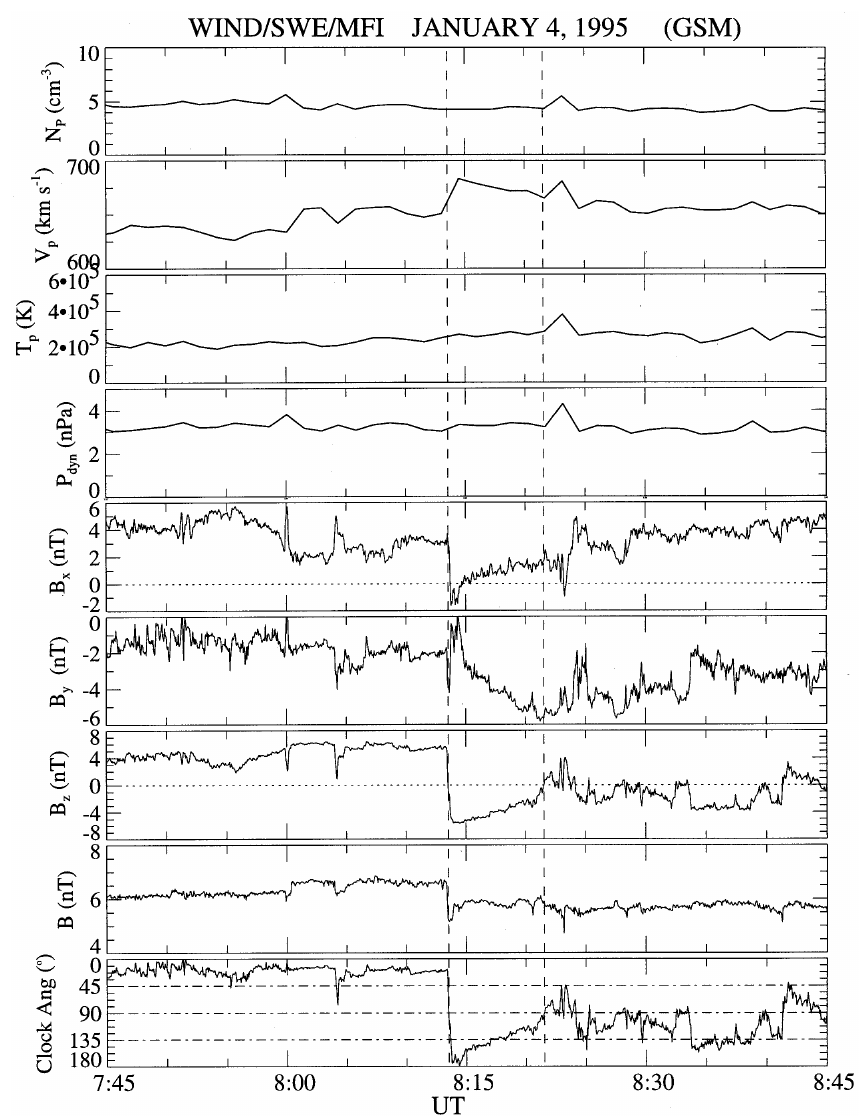
Fig. 1. Solar wind plasma and interplanetary magnetic field (IMF) data obtained from spacecraft WIND during the interval 07:45–08:45UT on 4 January 1995. Panels from top to bottom show proton density, bulk speed, temperature, dynamic pressure, the GSM components of the magnetic field, the total field, and the IMF clock angle. The rapid southward turning at 08:13UT (first vertical line) is the focus of this paper.